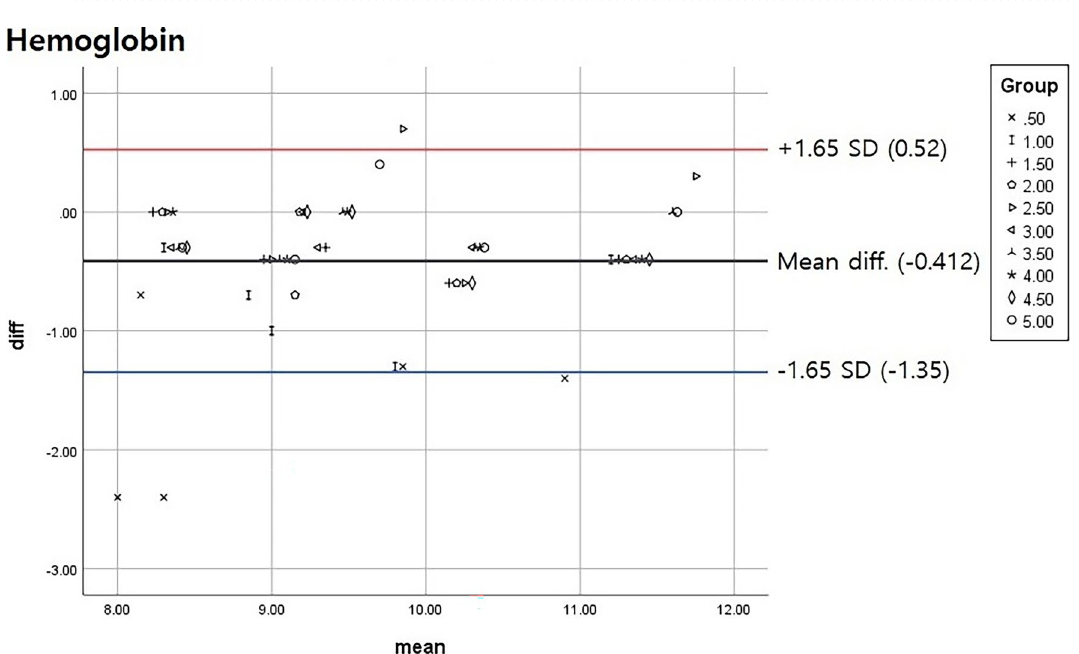
Figure 3. Hemoglobin results for each clearing volume group. Some results from the 0.5 and 1 mL clearing groups were just within the 90% confidence interval (Total n = 50). SD standard deviation, diff